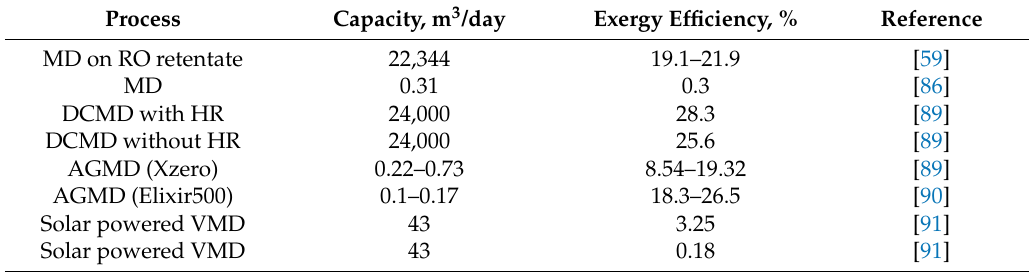
Figure 16. GOR and second law efficiencies in desalination processes based on entropy generation. Table 8. A summary of different membrane distillation process exergy